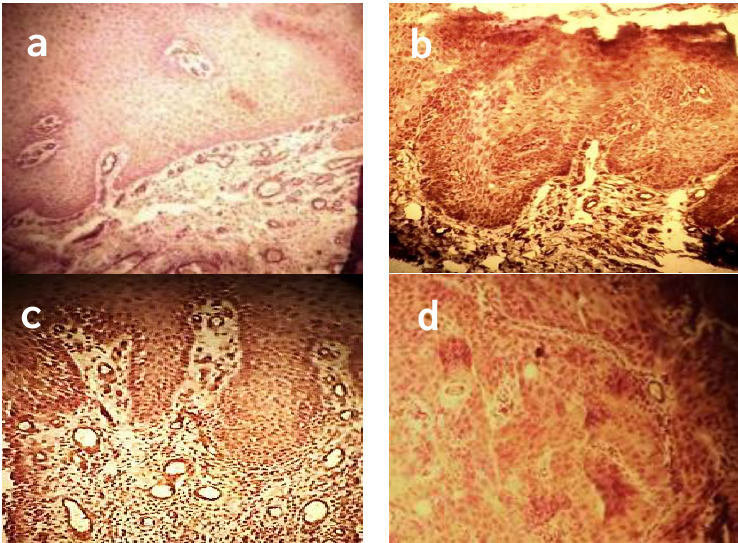
Figure 2 :Immunohistochemical expression of CD34 in (a) gingival mucosa. (b) proliferative verrucous leukoplakia. (c) oral lichen planus with mild dysplasia. (d) oral squamous cell carcinoma.